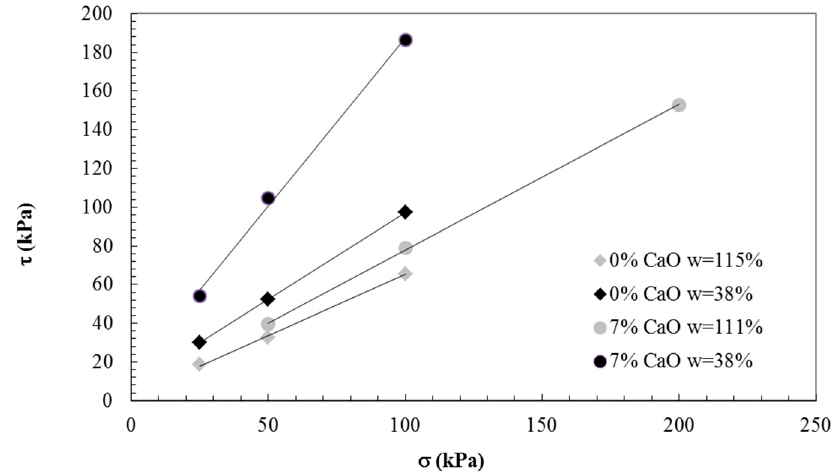
Figure 11. Mohr–Coulomb peak failure envelopes obtained from direct shear tests, for specimens of treated (7% CaO) and untreated soil compacted at di ff erent water treated (7% CaO) and untreated soil compacted at different water contents.